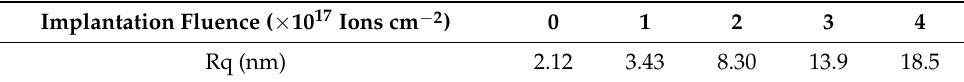
Table 1. Surface roughness of N–A TiAl film with various 20 keV helium implantation fluences. Rq is the root mean square roughness.